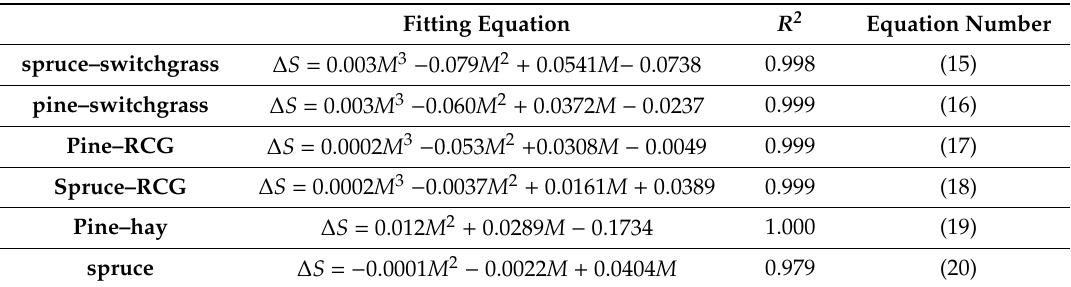
Table 5. Variation of the di ff erence in entropy as function of